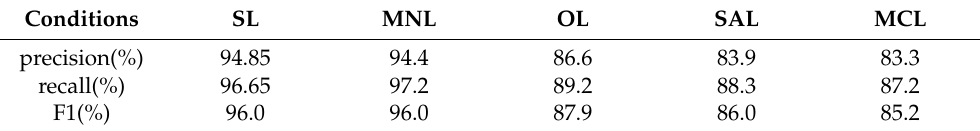
Figure 5. Examples of instance segmentation of pests: ( a1 , a2 ) Single larva of Heortia vitessoides and the corresponding instance segmentation result. ( b1 , b2 ) Single larva of Heortia vitessoides affected by shadows and the corresponding instance segmentation result. ( c1 , c2 ) Single larva of Heortia vitessoides sheltered by leaves and the corresponding instance segmentation result. ( d1 , d2 ) Multiple non-overlapped larvae of Heortia vitessoides and the corresponding instance segmentation result. ( e1 , e2 ) Multiple non-overlapped larvae of Heortia vitessoides affected by shadows and the corresponding instance segmentation result. ( f1 , f2 ) Multiple larvae of Heortia vitessoides affected by uneven color on the surface and the corresponding instance segmentation result. ( g1 , g2 ) Multiple clustering larvae of Heortia vitessoides affected by shadows and occlusion and the corresponding instance segmentation result. ( h1 , h2 ) Multiple clustering larvae of Heortia vitessoides affected by uneven color on the surface and occlusion and the corresponding instance segmentation result. ( i1 , i2 ) Multiple clustering larvae impacted by uneven color on the surface, occlusion, and shadow, as well as the related segmentation result for the instance. Table 2. Segmentation results of pests under different